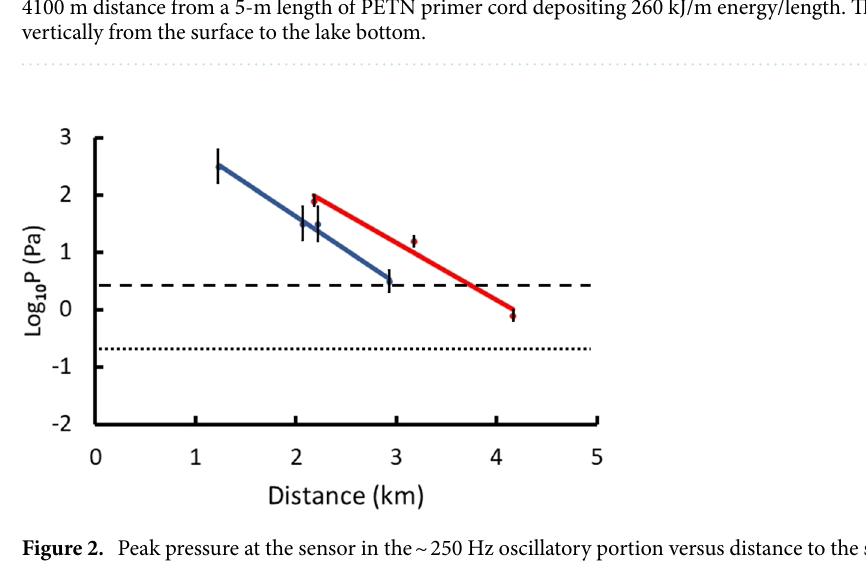
Figure 2. Peak pressure at the sensor in the ~ 250 Hz oscillatory portion versus distance to the source for explosive calibrations using 130 kJ/m (blue) and 260 kJ/m (red) charges, each 5 m long. The two horizontal lines give the pressure that will trigger recording 80% (dashed line) and 20% (dotted line) of the total observation time, as explained in the text and in Supplemental Information on Methods: Variation in trigger level from weather